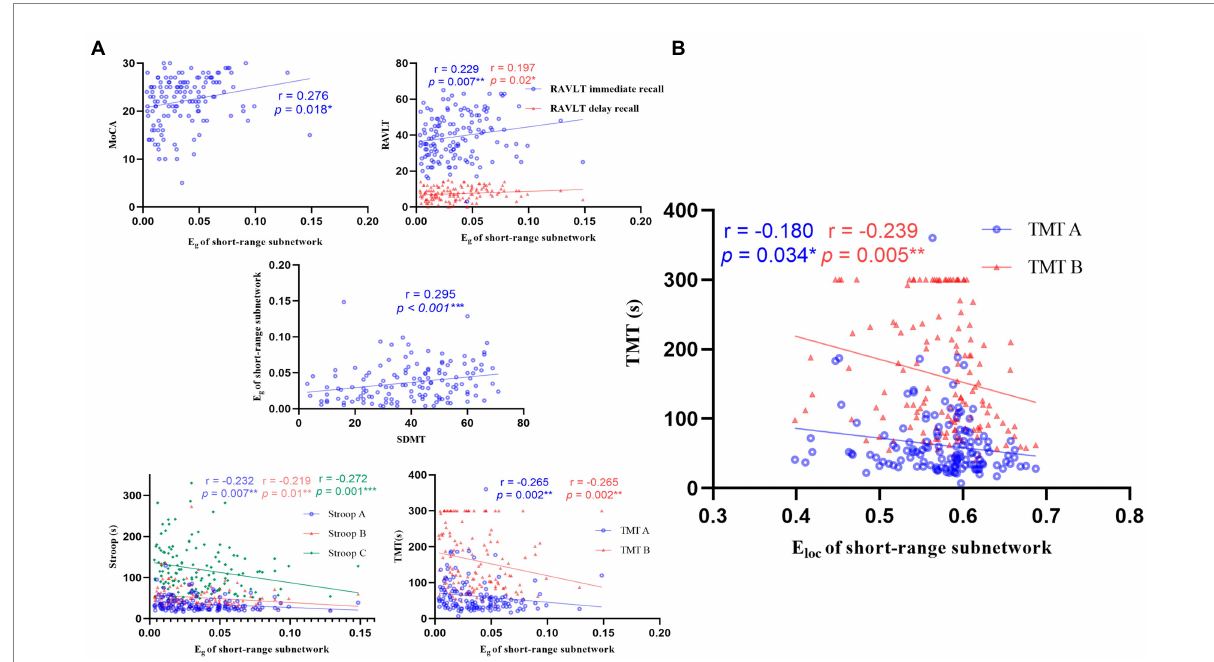
FIGURE 5 Correlations between the global metrics (E g , E loc ) of short-range subnetwork and cognitive scale. (A) Correlations between the E g of short-range subnetwork and cognitive scale. The E g of short-range subnetwork was negatively correlated with cognition function ( n = 139, p < 0.05). (B) Correlations between the E loc of short-range subnetwork and TMT. MOCA: Montreal cognitive assessment; RAVLT: Rey auditory verbal learning test; SDMT: symbol digit modalities test; Stroop: Stroop color-word test; TMT: trail-making